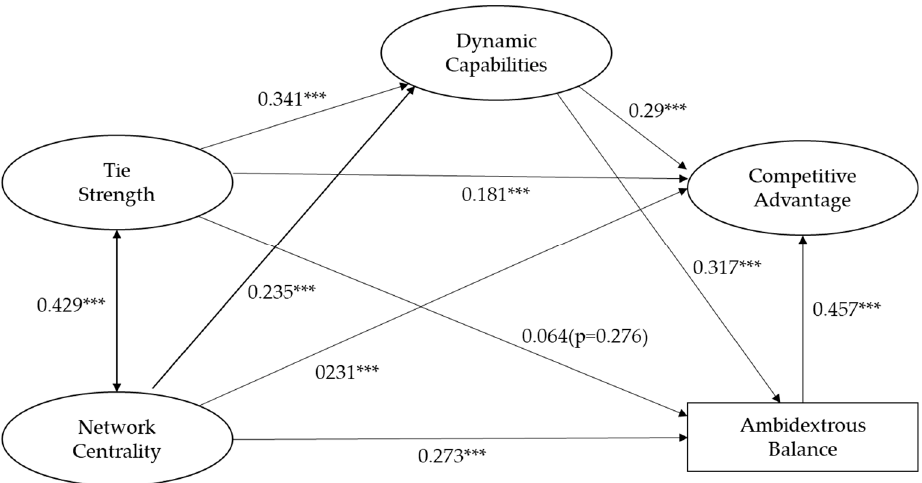
Figure 2. The results of standard path coefficient in the SEM model. *** is p < 0.001.